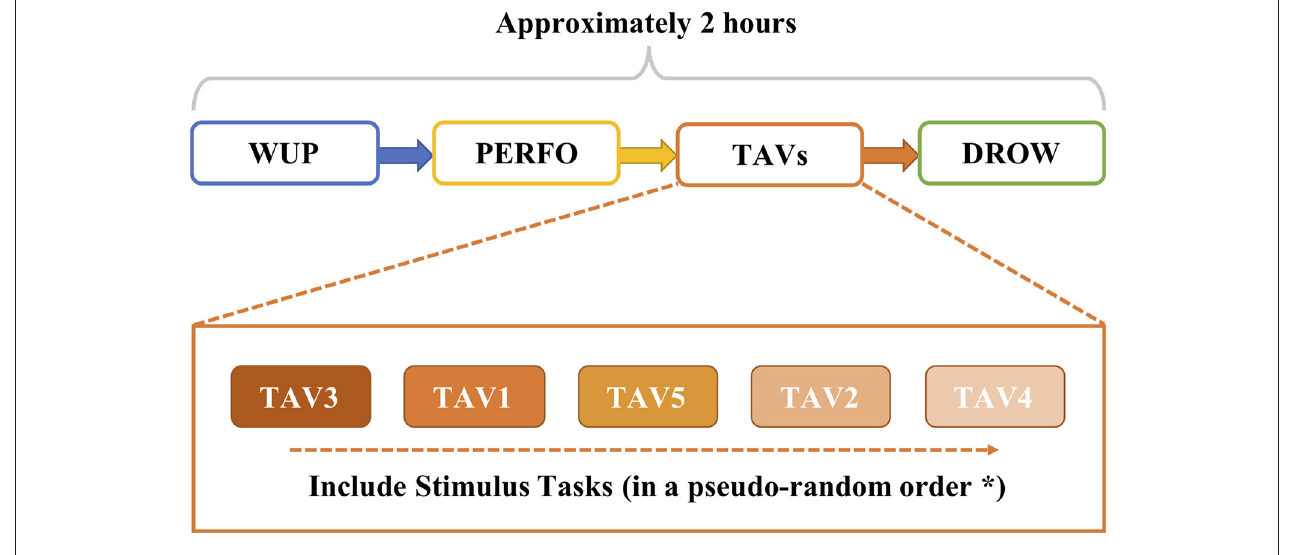
FIGURE 1 | The procedure of experimental paradigm (*all the subjects will perform the task of alert and vigilance (TAV) tasks in the same order).